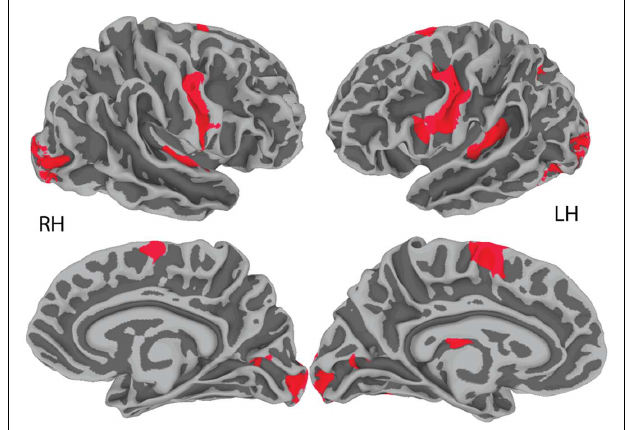
FIGURE 1 | Group-level ( N = 20) conjunction map (sentence repetition ∩ sentence generation). FWE-corrected joint activation is shown on the group average smoothed white matter folded surface.